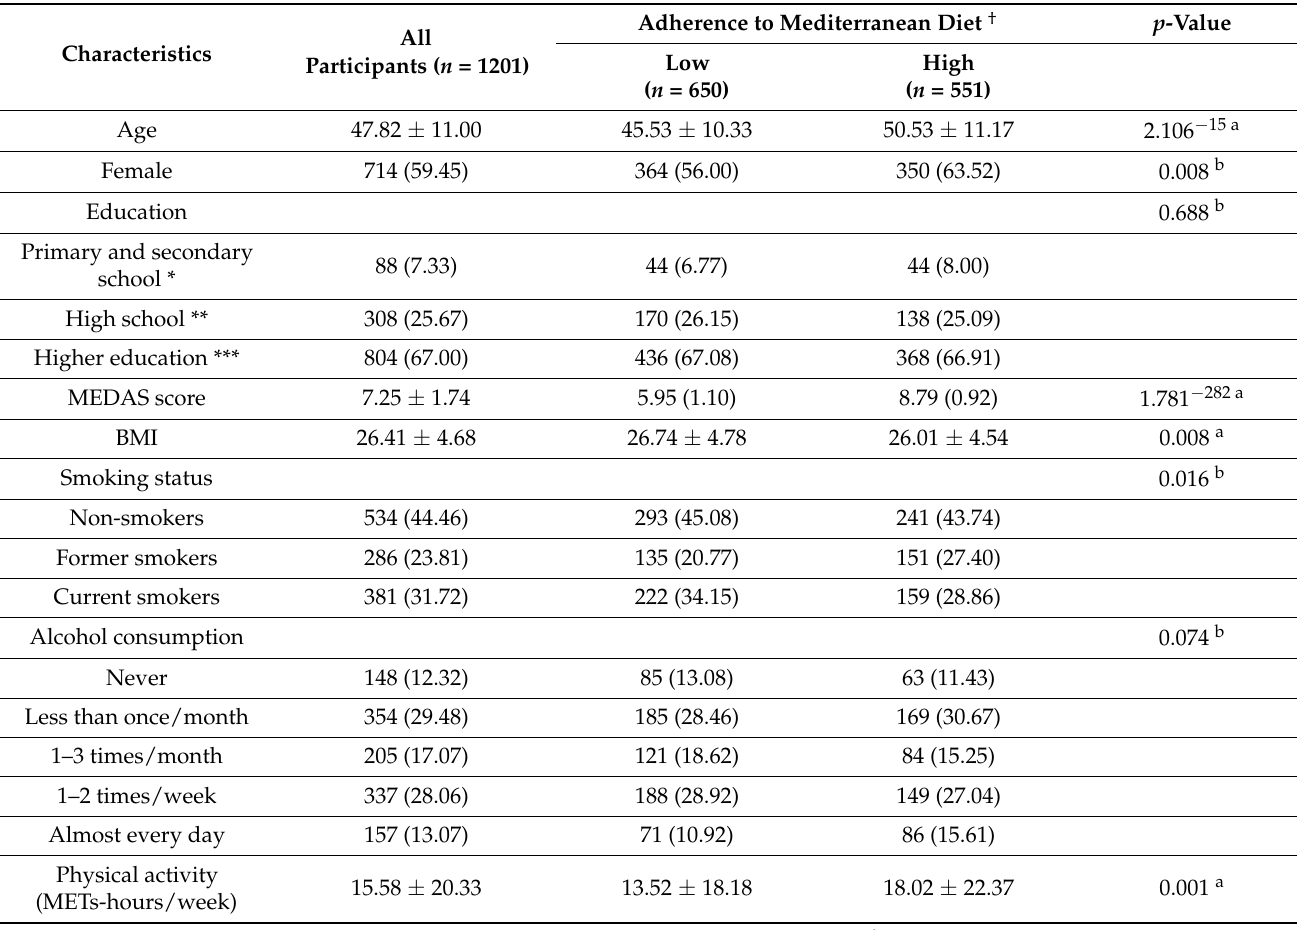
Table 1. Sociodemographic and lifestyle characteristics of Epirus Health Study participants by level of adherence to the Mediterranean